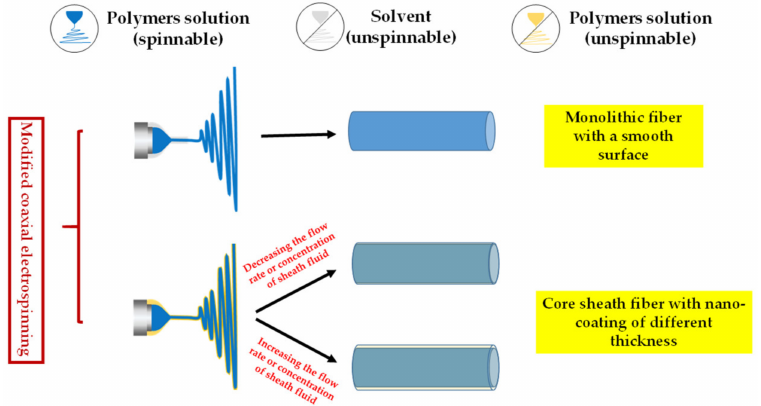
Figure 6. Modified coaxial electrospinning process.